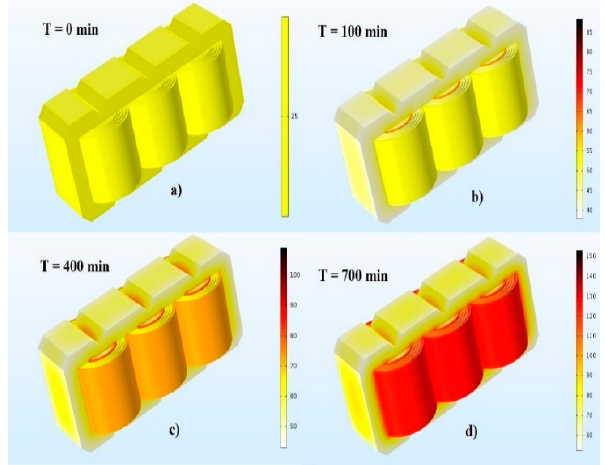
Figure 7. Transformer thermal field for ( a ) 0 min, ( b ) 100 min, ( c ) 400 min, and ( d ) 700 min.